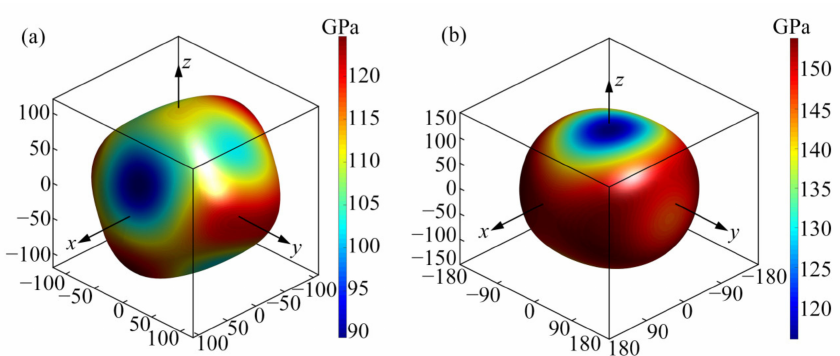
listed Table 7 for η (cid:48) -Cu 6 Sn 5 and Cu 3 Sn. The anisotropic degree of η (cid:48) -Cu 6 Sn 5 was similar in the yz , xz , and xy planes. For Cu 3 Sn, G max = 63.1 GPa, G min = 46.1 GPa, and the G max / G min